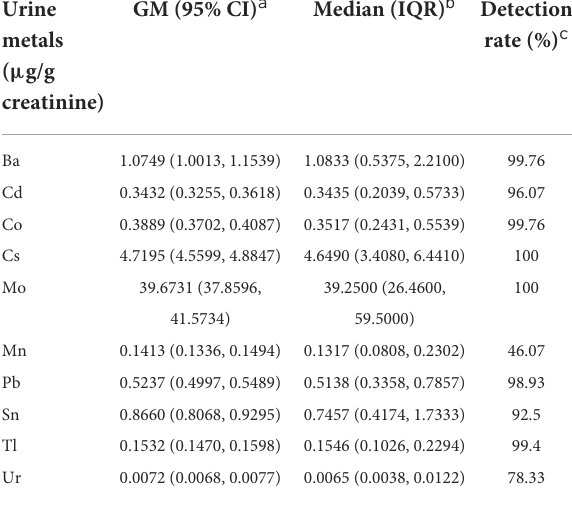
TABLE 2 Geometric means, quartiles and detection rates of urine